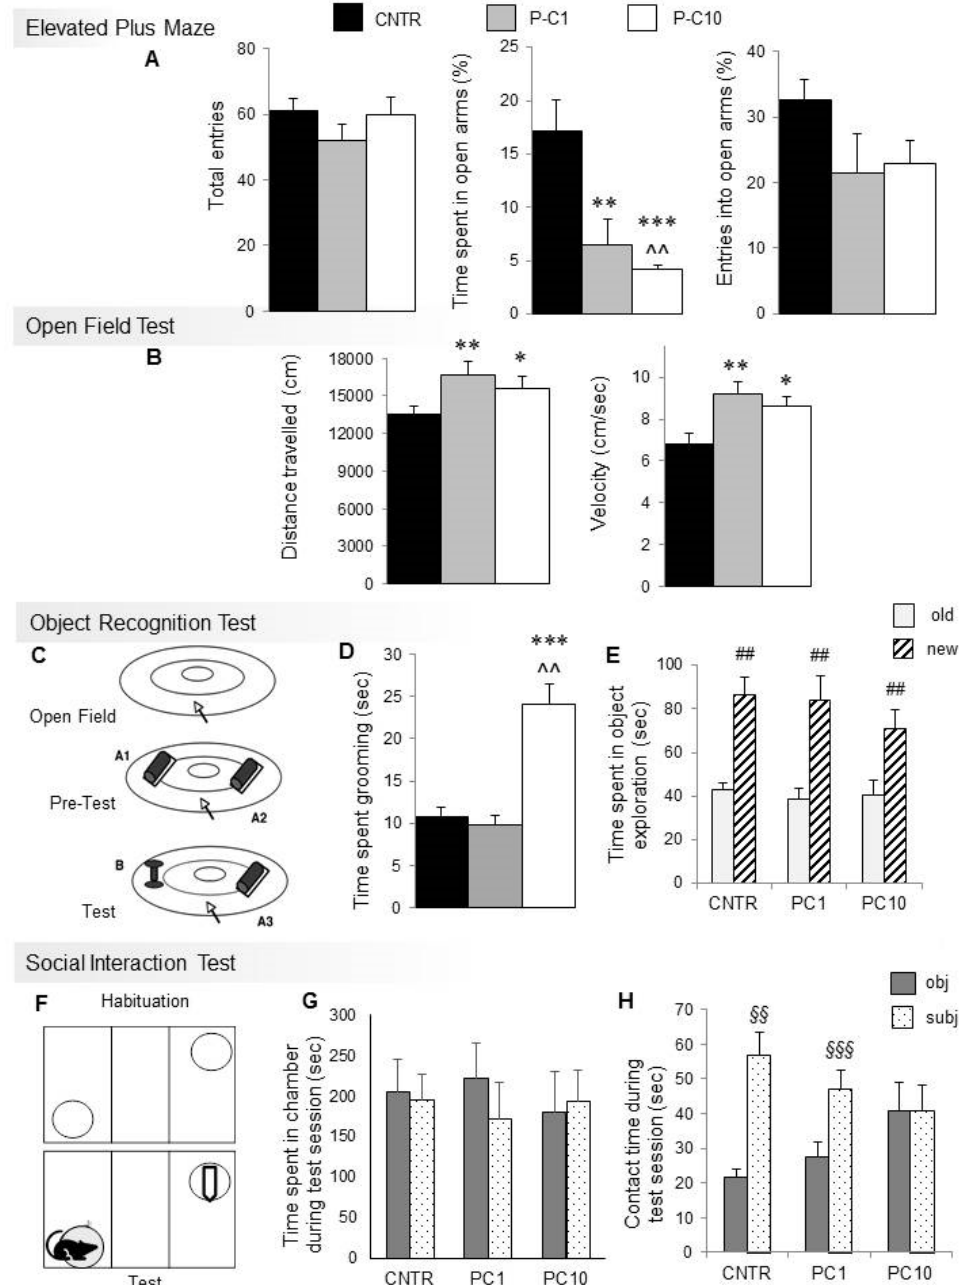
Figure 1. P -cresol enhances anxiety-like behaviors, stereotypies, locomotor parameters and hinders social preference in BTBR mice. ( A ) Total entries, % of time spent and entries in open arms in the Elevated Plus Maze. ( B ) Distance travelled and speed in the Open Field Test after acute p -cresol treatment. ( C ) Schematic representation of the Object Recognition Test. ( D ) Time spent grooming during the first session of the Object Recognition Test. ( E ) Time spent exploring the novel or familiar object during the test session of the Object Recognition Test. ( F ) Schematic representation of the three-chamber Social Interaction Test. ( G ) Time in object and subject zones during the Social Interaction Test session. ( H ) Time spent in contact with the object or with the social intruder during the Social Interaction Test. Results are shown as mean ± sem. *, **, *** p < 0.05, p < 0.01, p < 0.001 P-C1 or P-C10 vs. CNTR. ˆˆ p < 0.01 P-C10 vs. P-C1, ## p < 0.01 old vs. new, §§ , §§§ p < 0.01, p < 0.001 subject vs.